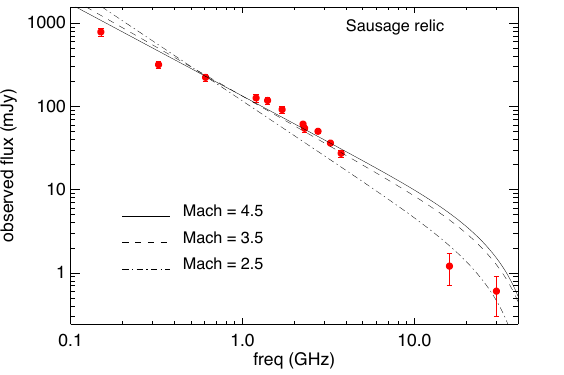
Figure 3. Fit to the actual relic flux measurements for the “Sausage” relic in CIZA J2248.8 + 5301 ( left ), and the “Toothbrush” relic in 1RXS J0603.3 + 4214 ( right ), against our model predictions for